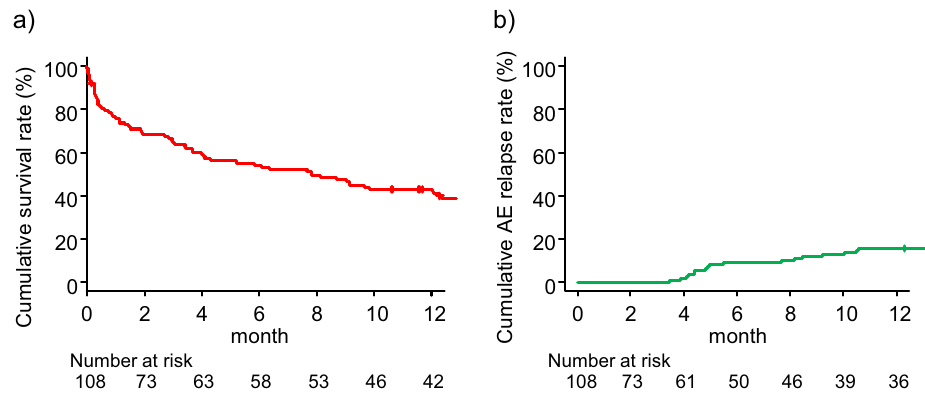
Figure 2. Post-AE cumulative survival and AE relapse rates. ( a ) The post-AE 90-day and 1-year cumulative survival rates were 63.9% (95% confidence interval [CI] 55.7–73.6) and 42.6% (95% CI 32.6–51.1), respectively,